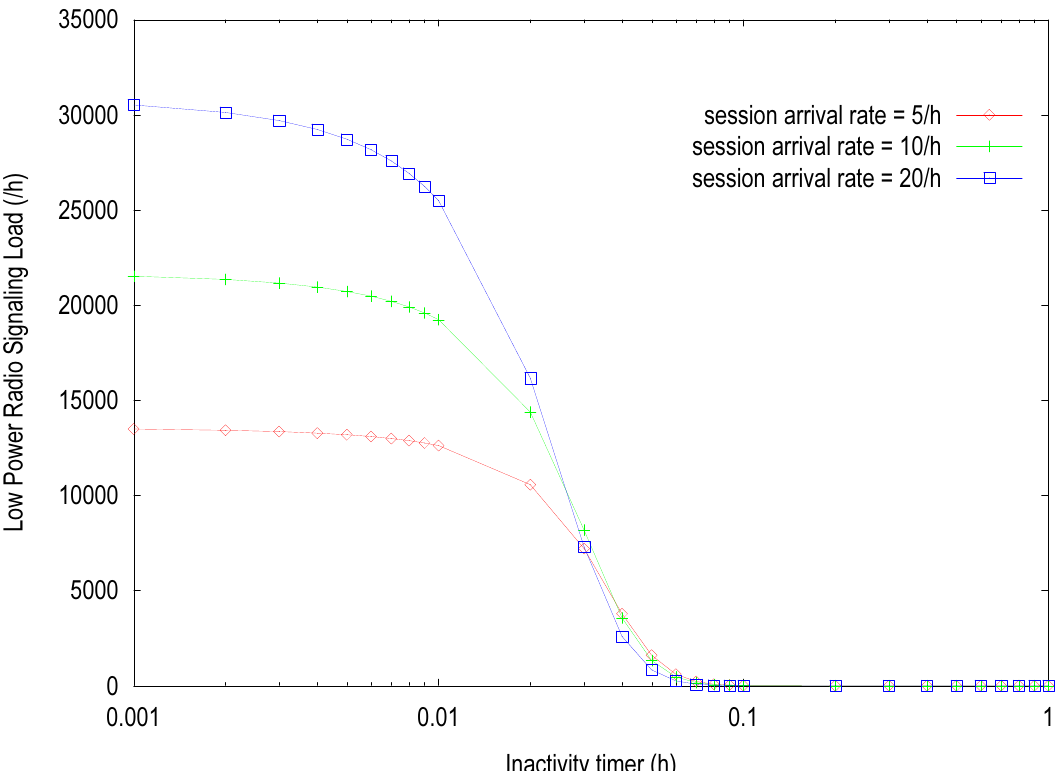
Figure 11. Low-power radio signaling load by varying the session arrival rate (large values of T and T E W